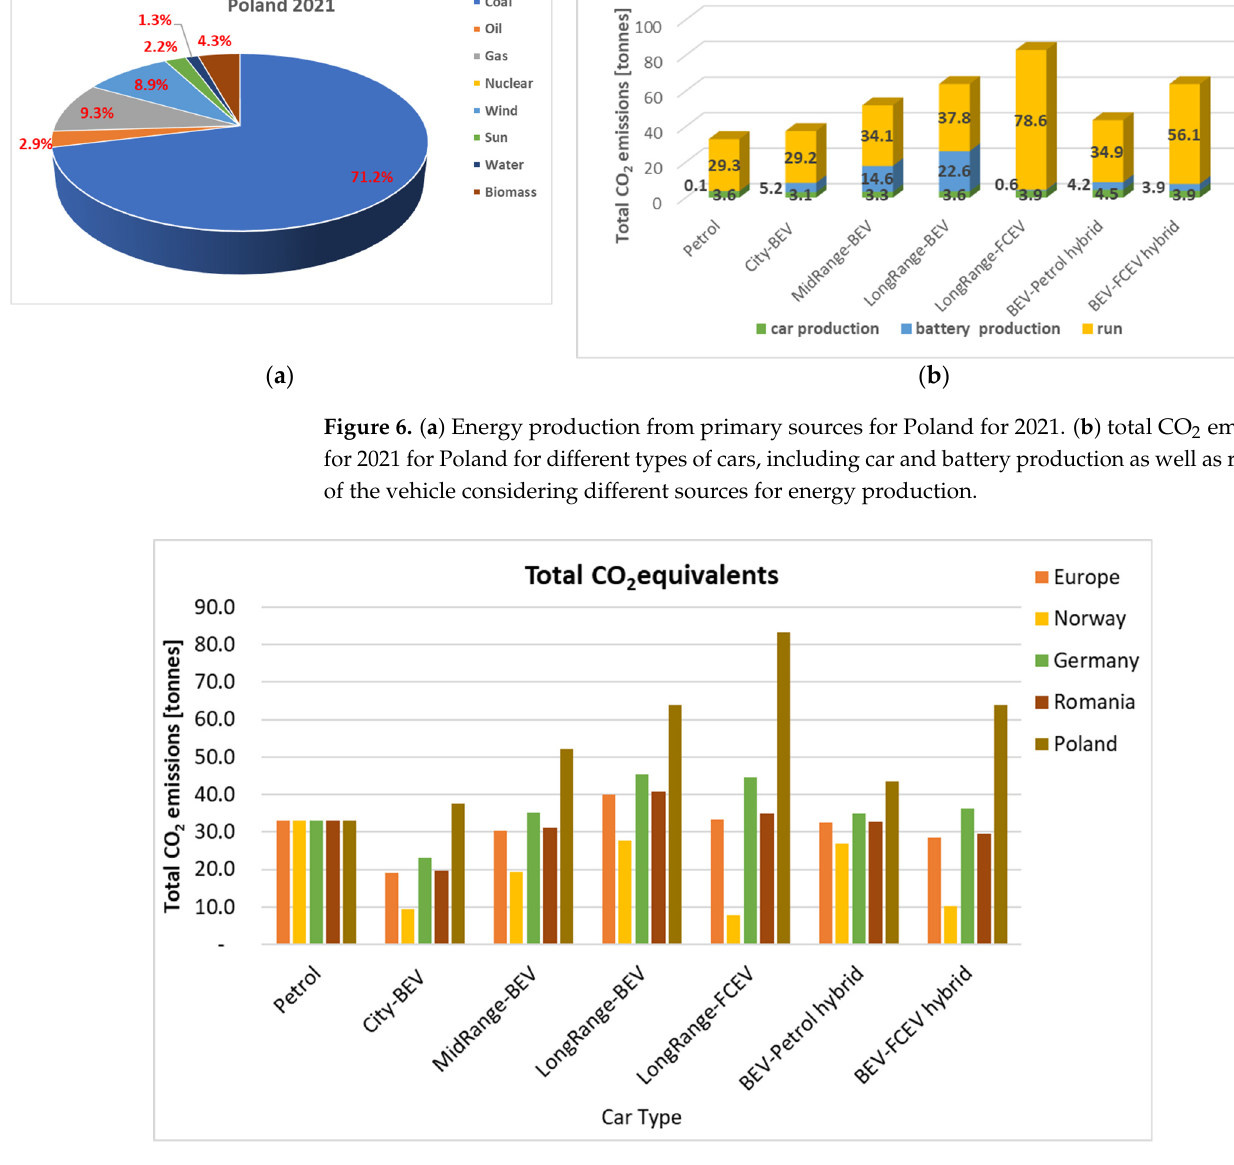
Figure 7. Comparative CO 2 equivalent emissions for Norway, Germany, Romania, Poland and Europe for 150 and 500 km cruising range for BEVs and 500 for all other vehicle types.